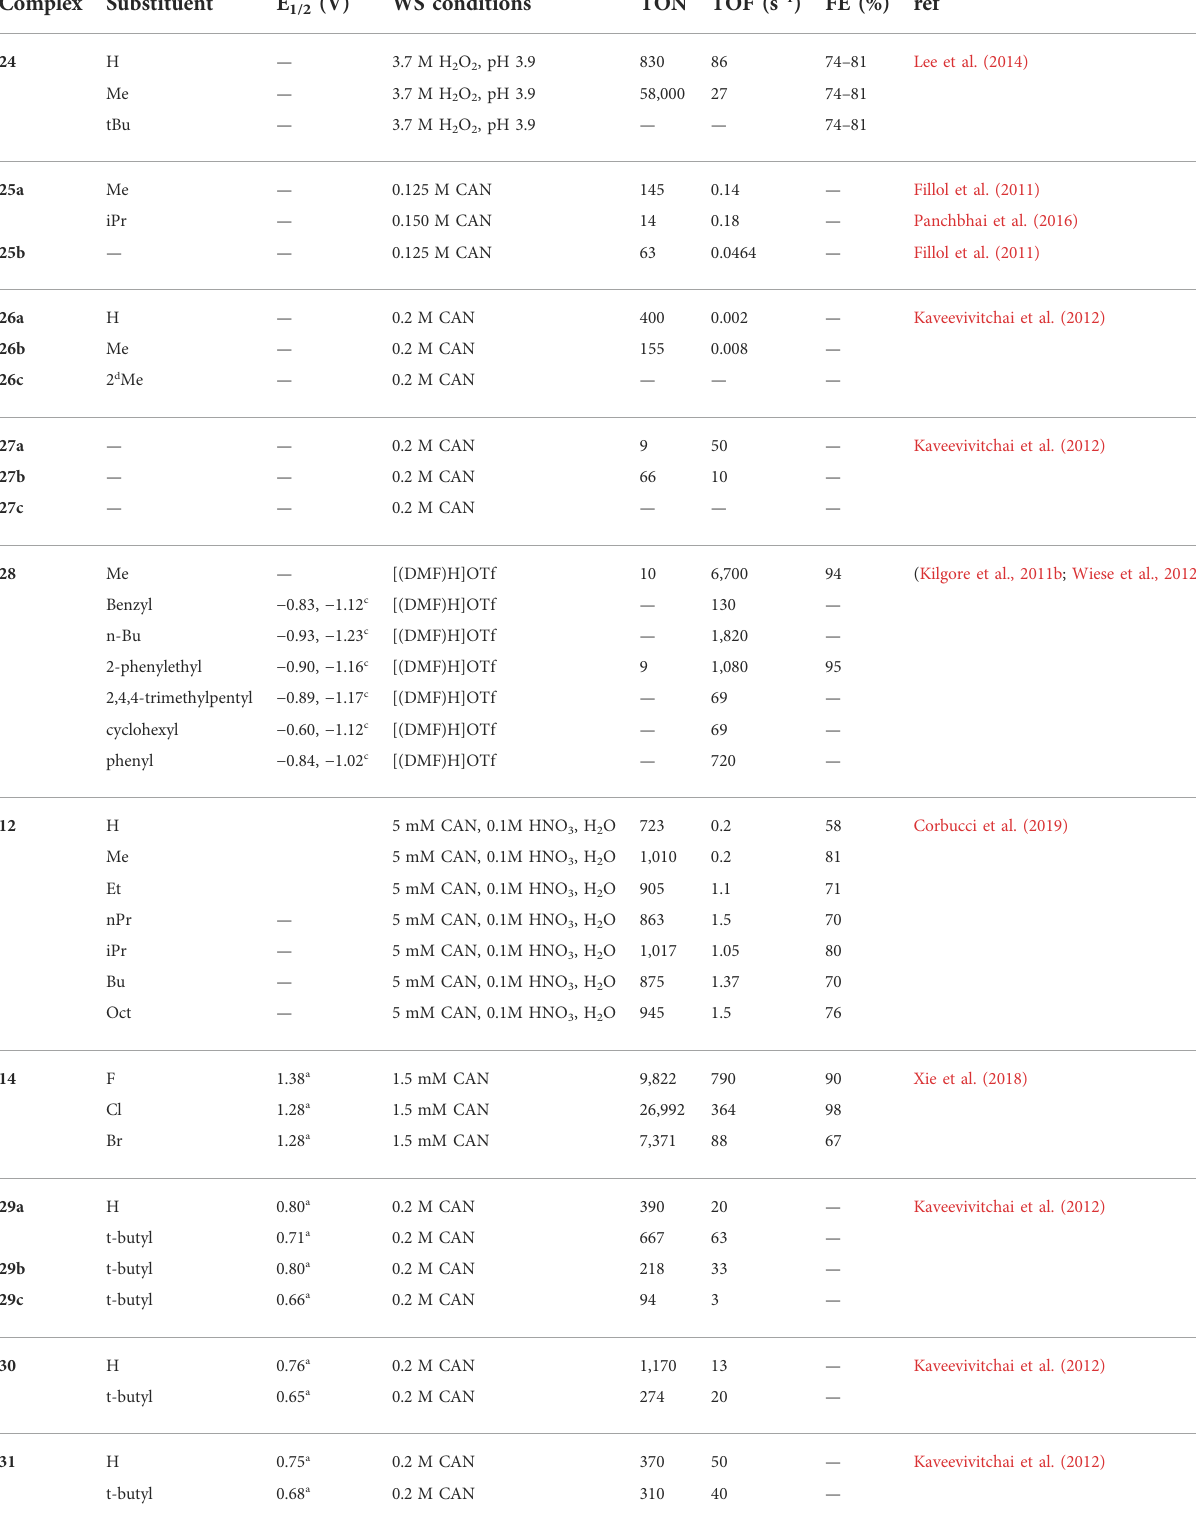
TABLE 3 Properties of metal complexes with different steric hindrance effect. Complex